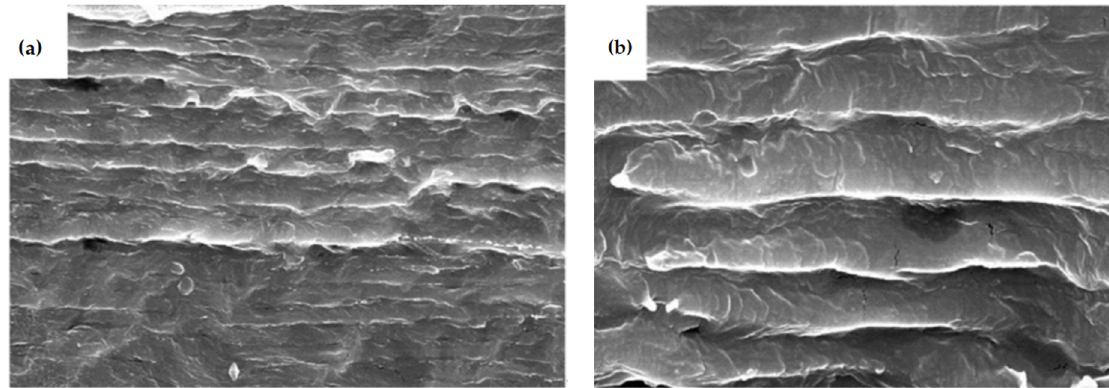
Figure 3. SEM micrographs of the graphene/PVDF composite containing graphene volume fractions of 0.0177 ( a , b ) [38].